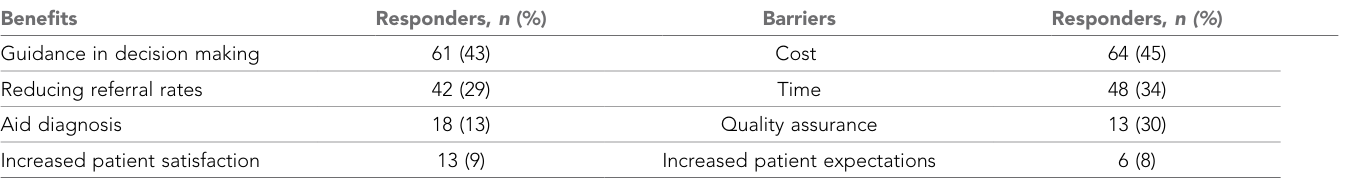
Table 1. Main benefits for and barriers to GPs using POCTs in their practice Benefits Responders, n (%) Guidance in decision making Aid